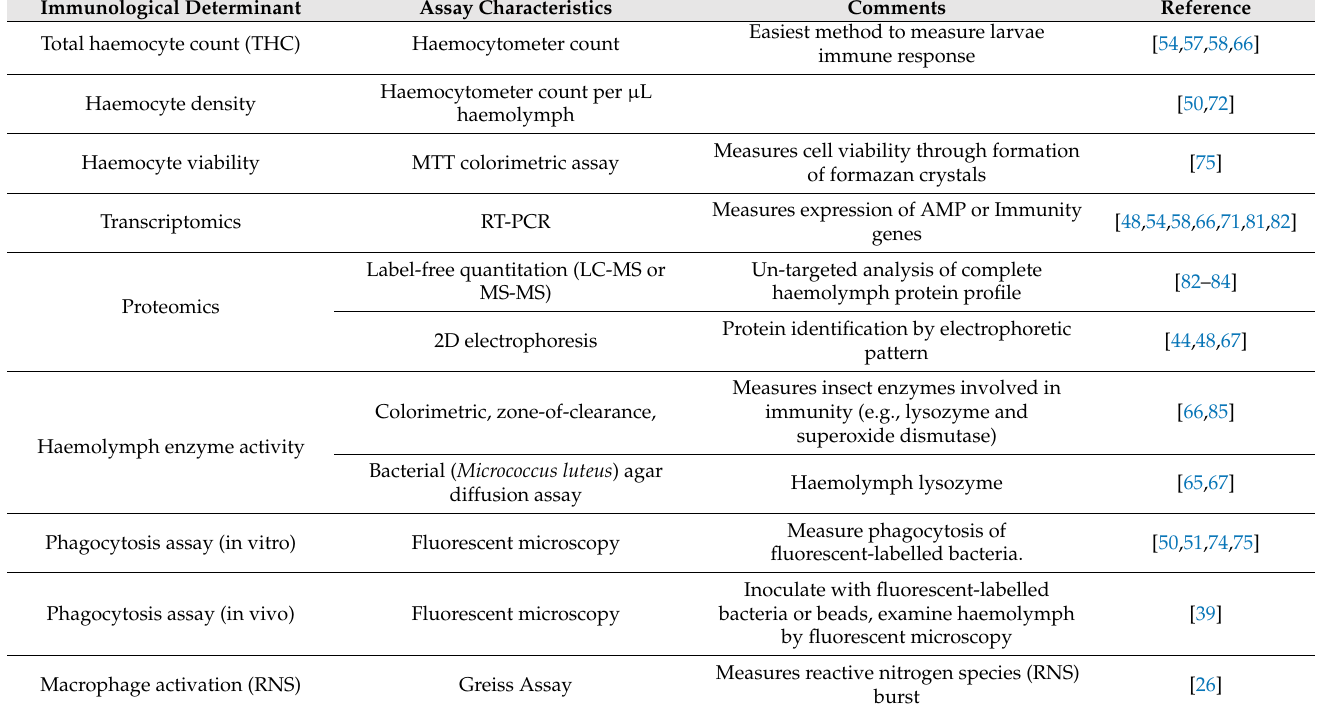
Table 2. Available techniques to evaluate natural product-derived immunomodulators in Galleria mellonella insect model of innate